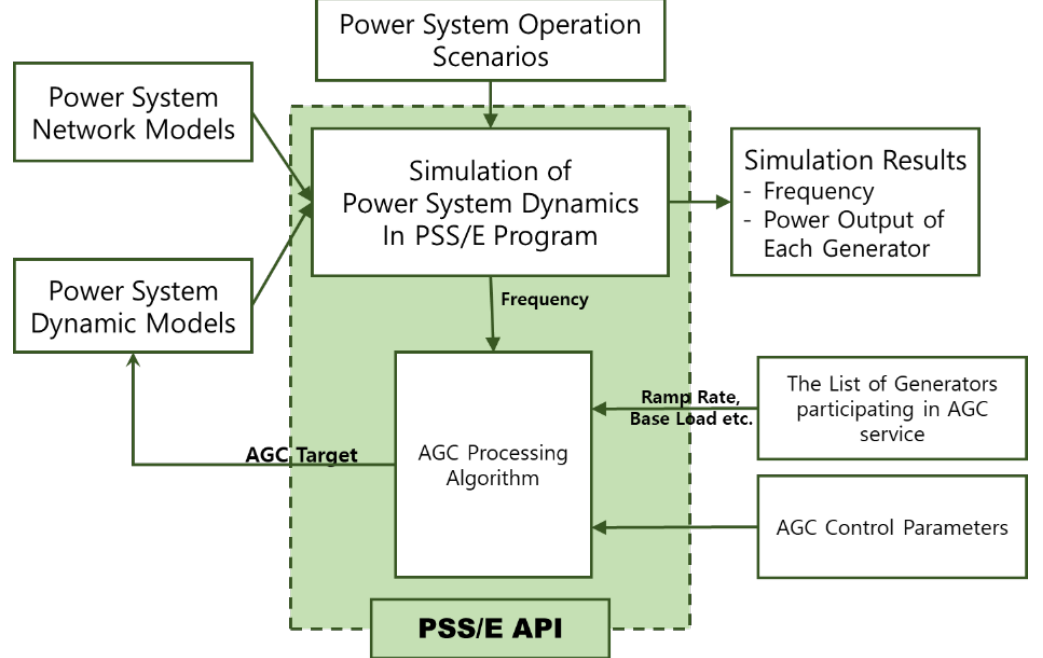
Figure 4. Simulation framework for AGC in the Korean power system.